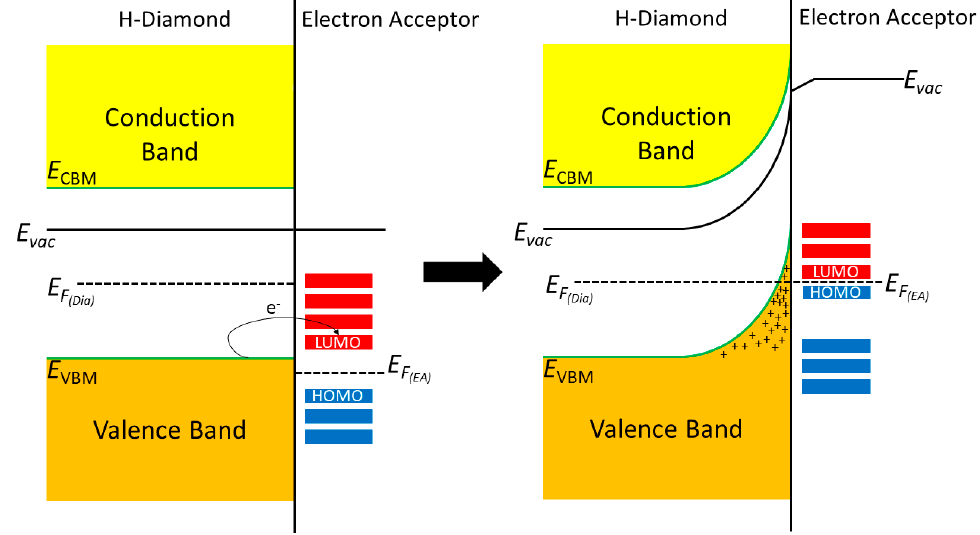
Figure 1. Band diagrams showing the interaction of hydrogen terminated diamond with a surface electron acceptor material.